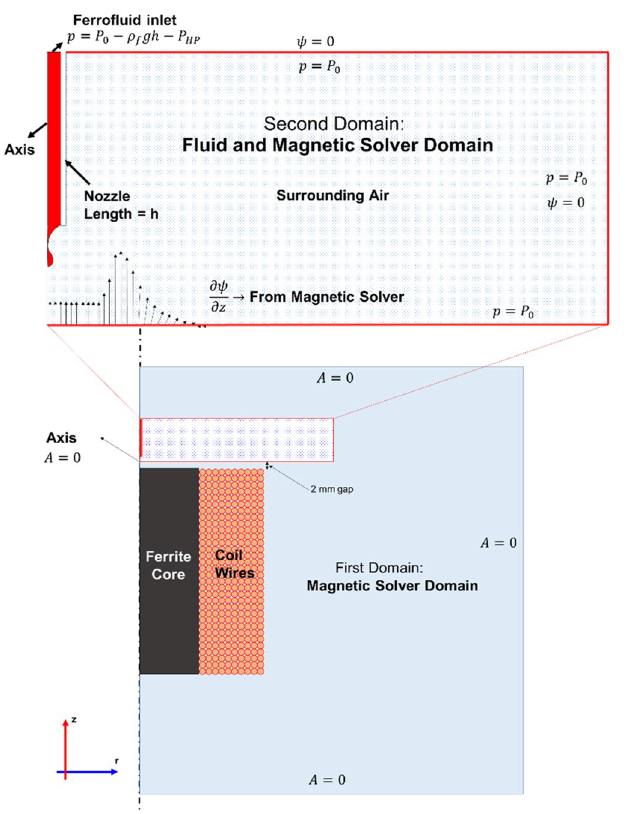
Figure 2. The magnetic and fluid boundary conditions assumed for the two assumed computational